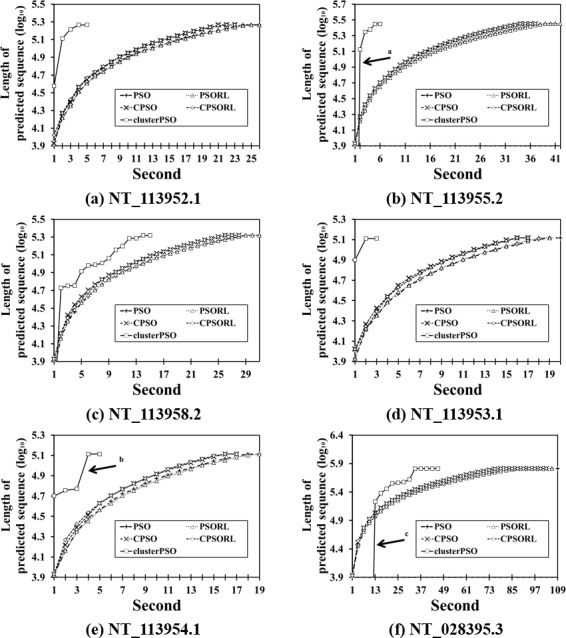
Comparison of CPU time and search efficiency amongst six methods for the six contig sequences.The CPU times for PSO, CPSO, PSORL, CPSORL and ClusterPSO are shown to assess relative search efficiency in the six contig sequences. The horizontal axis represents the implementation time, and the vertical axis represents the log10 value for the presently-detected position in the sequence. Arrows a and c show that the CpGcluster step handles long sequences, hence sequence scanning may proceed more slowly at first than in other methods. Arrows a, b and c show that the CpGcluster step detects very few CpG island candidates in the region.